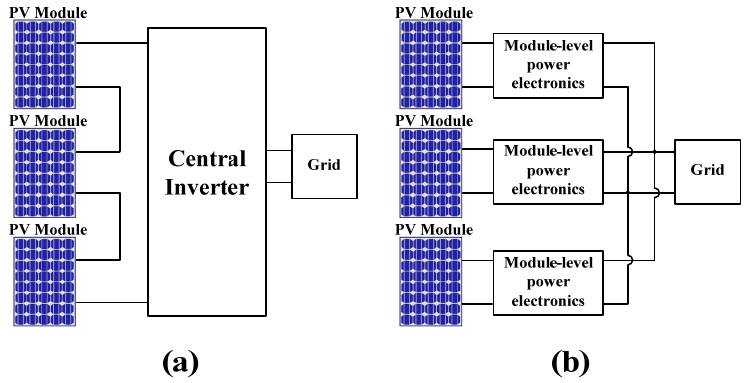
Figure 1. Block diagrams of ( a ) the central inverter and ( b ) the module-level power electronics.